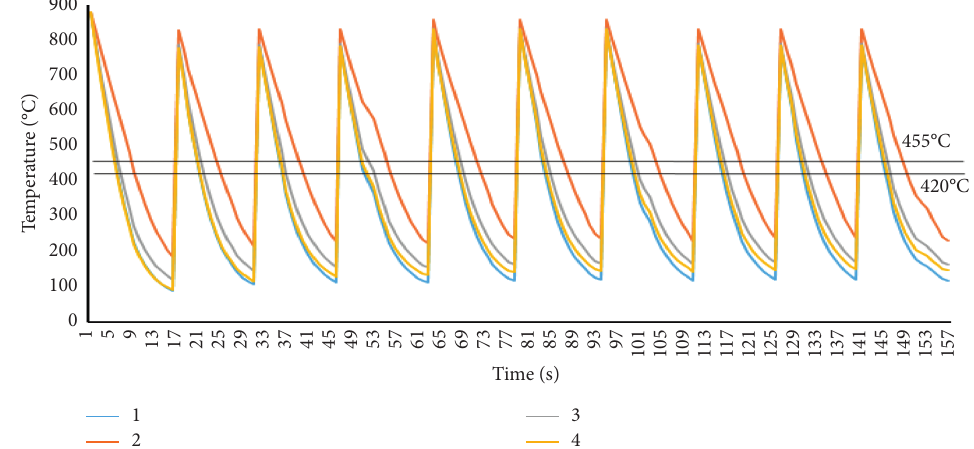
Figure 10: Change rule of reference points’ temperature during the synchronous quenching process in quantity